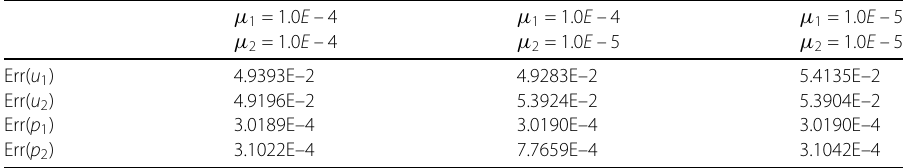
Table 4 Errors for the different small viscosities based on stabilized P 2 – P 2